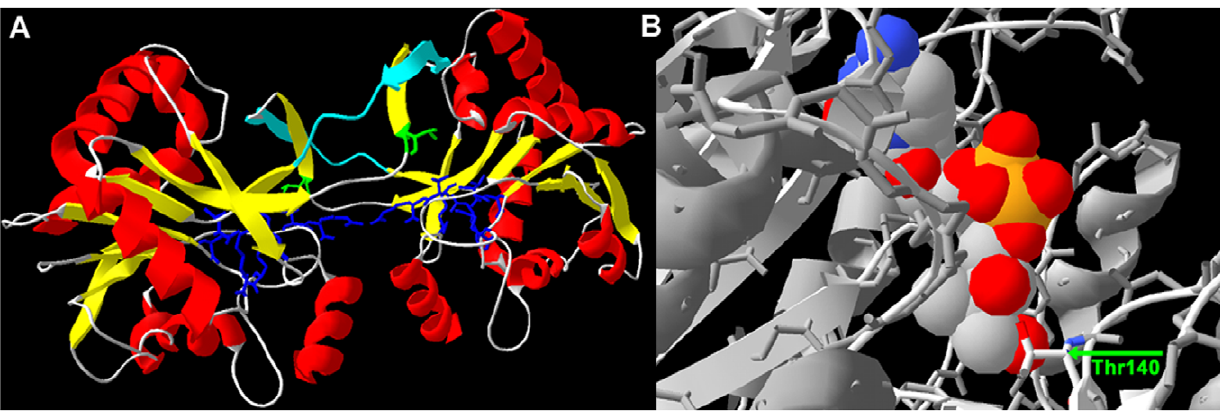
Figure 6. Structural features of the MEP cytidylyltransferase. A) Predicted structure of the F. tularensis MEP cytidylyltransferase, homology- modeled using templates selected by I-TASSER’s threading alignment algorithm. A cartoon representation of the dimeric enzyme is shown, with alpha helices colored red, beta sheets colored yellow, and coiled regions colored gray. ProQRes was used to evaluate the quality of the model (Fig. S2), providing scores ranging from 0 (unreliable) to 1 (reliable). Regions of the model scoring , 0.5 are colored light blue. Residues comprising the substrate binding site (colored dark blue with backbone and sidechain residues shown) were identified via primary sequence alignment and the resolved structure of E. coli MEP cytidylyltransferase [15]. Threonine141 (colored green with backbone and sidechain residues shown) is equivalent to E. coli Thr140. B) Active site of the E. coli MEP cytidylyltransferase co-crystallized with CDP-ME (PDB accession code 1INI). Thr140 (arrow) hydrogen bonds to the C1 and C3 hydroxyl oxygen atoms of CDP-ME [15,18].